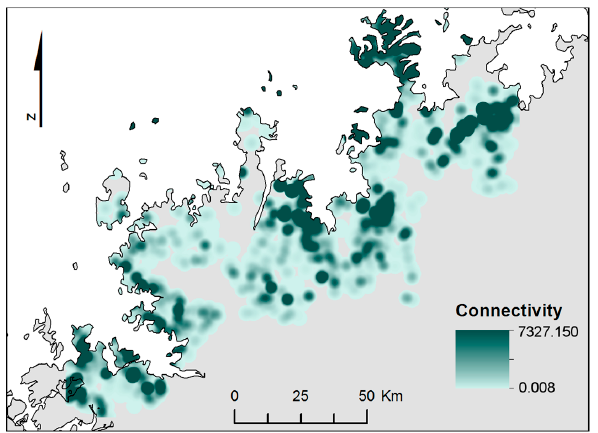
Figure 3. Patch connectivity of rain forests in WGC. Patches with high connectivity (dark shade, up to 7327.150) are larger and/or closer together than patches with low connectivity (light shade, down to 0.008).